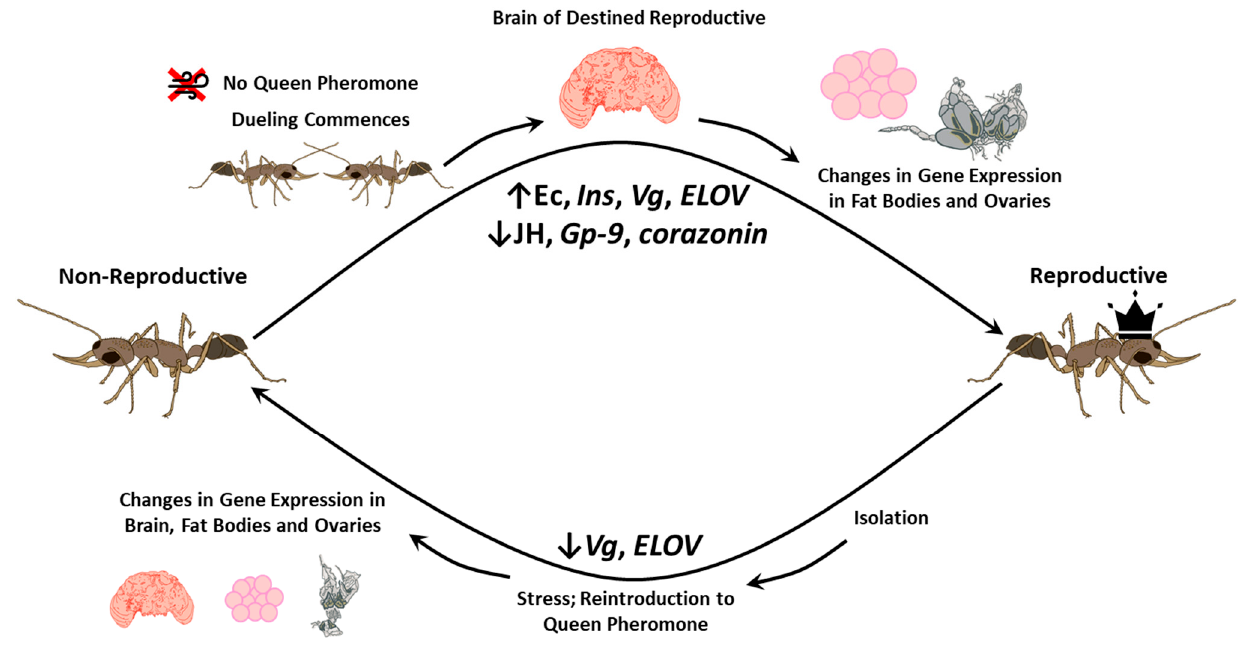
Figure 3. Harpegnathos saltator workers undergo changes in gene expression and tissue structure to become reproductive gamergates. In the absence of queen pheromones, workers will commence dueling, a behavior in which antennal strikes are rapidly exchanged between workers. Victors will become destined reproductive. Changes in gene expression in the brain will trigger gene expression changes in fat bodies and ovaries, eventually resulting in reproductive status. The gamergate state is not permanent and can be reversed following isolation and subsequent introduction to the pheromone of another reproductive. Changes in gene expression and tissue structure undergo reversion, and the gamergate behaves like a regular worker once again. The brain figure is adapted from Smith et al., 2016 [109], and the ovary images are adapted from Gospocic et al., 2017 [32].